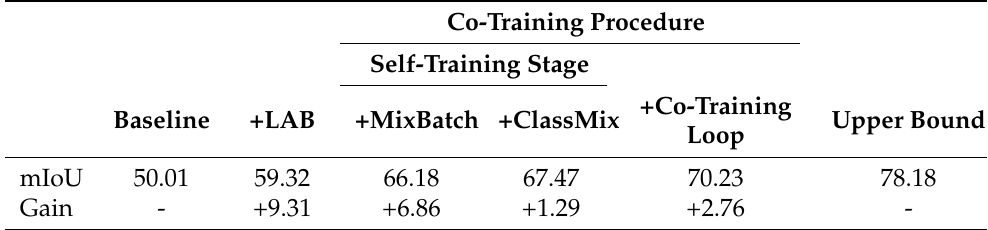
Table 4. Contribution of the main components of our proposal. Case study: GTAV + Synscapes →